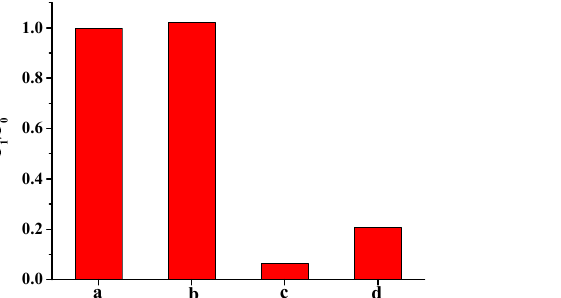
Figure 13. The fluorescence ratios of (a) DNA2-Ag NCs, (b) DNA2-Ag NCs/EDTA, (c) DNA2-Ag NCs/Cu 2+ , and (d) DNA2-Ag NCs/Cu 2+ /EDTA. From the circular dichroism spectrum in Figure 14, the DNA2-Ag NCs have positive and negative absorption peaks at 275 nm and 245 nm, respectively, showing a typical B-type DNA conformation [14]. After the addition of Cu 2+ , the absorption peaks at 245 nm and 275 nm obviously redshifted, which was associated with the changes in the DNA template microenvironment [38]. This result confirmed the occurrence of the interaction between the Cu 2+ and oligonucleotide chains. Therefore, we hypothesized that both the carboxyl group (-COOH) and phosphonacyl group (-PO 3 H 2) in the glyphosate chelated with Cu 2+ , which destroyed the interaction between Cu 2+ and DNA2-Ag NCs, resulting in the recovery of the DNA2-Ag NCs’ fluorescence.